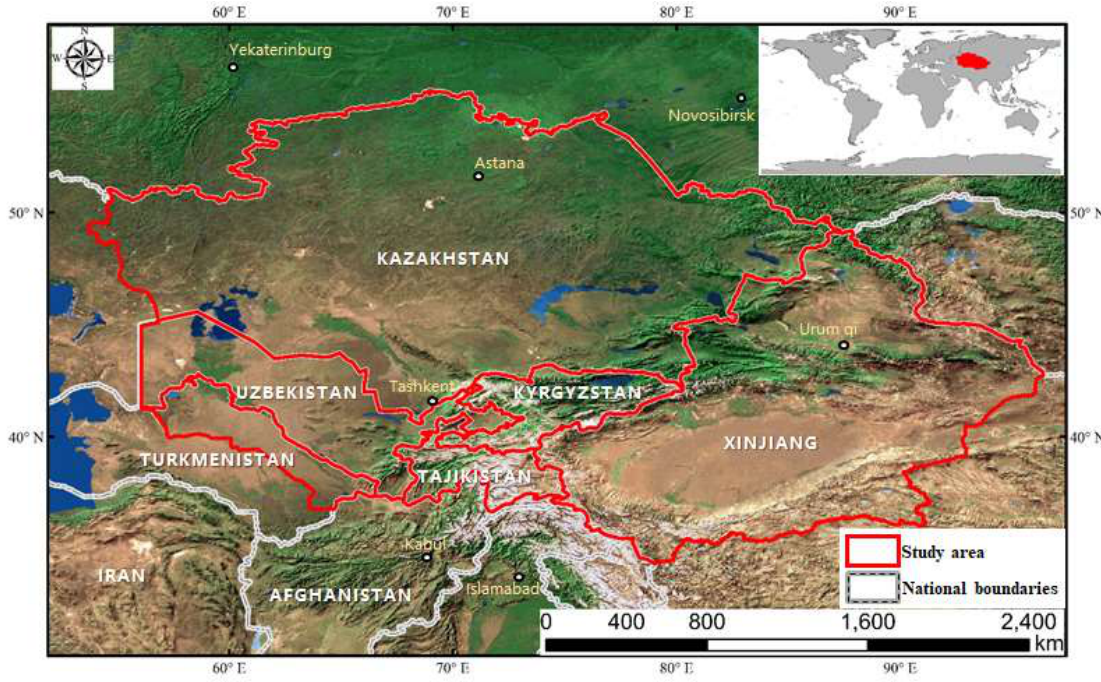
Figure 1. Extent of the study area (Kazakhstan, Uzbekistan, Turkmenistan, Kyrgyzstan, Tajikistan, and the Xinjiang Autonomous Territory of China, excluding the Caspian Sea basin).